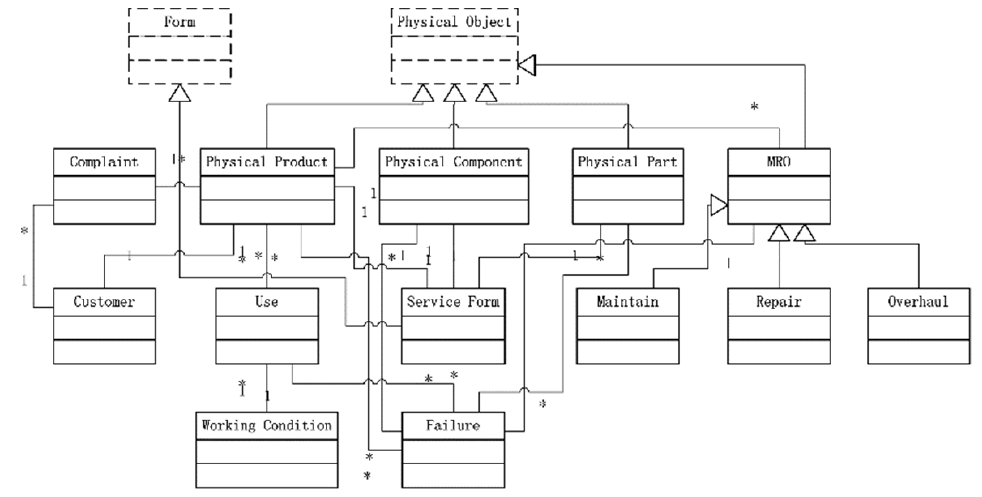
Figure 9. Service Private Data Model (1, * represent the one and multi-object). Recycling contains disassembly, cleanout, detection, reuse, remanufacturing, regenera- tion, burning, and Landfill. When out of service, physical products are taken to circulation economy enterprises. Physical products and components are disassembled, and the phys- ical parts are cleaned. After detection, some are reused directly in other products, and others are remanufactured to recover the performance, regenerated for the material then burned and landfilled. Based on PCDM, RPrDM is built, as shown in Figure 10. Physical Product and Physical Component are dismantled, and we obtain Physical Component, Physical Part, Material and Waste. Some can be reused. Blank, which is machined to a new Physical Part, comes from Material. Waste receives Innocent Treatment. A new Physical Product is presented by Remanufacture and Reassembly of Physical Component and Physical Part. All Physical Objects in the recycling phase have a Recycling Form for their recycling attributes. The content and management of the Process Route are the same as that for the Process Phase.